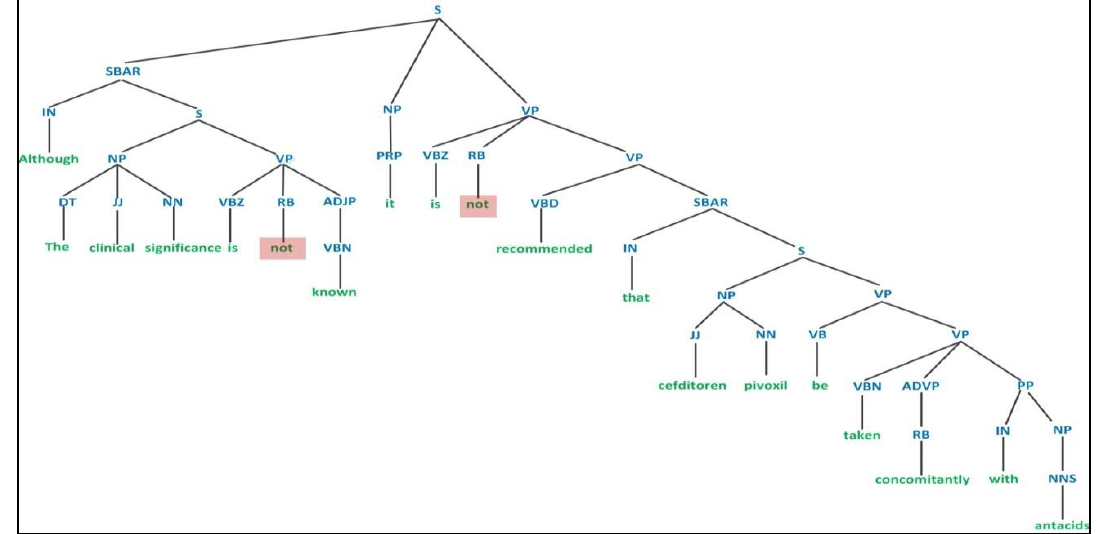
Figure 3. A sample of constituent parse tree of a complex sentence with two dependent clauses and two negation